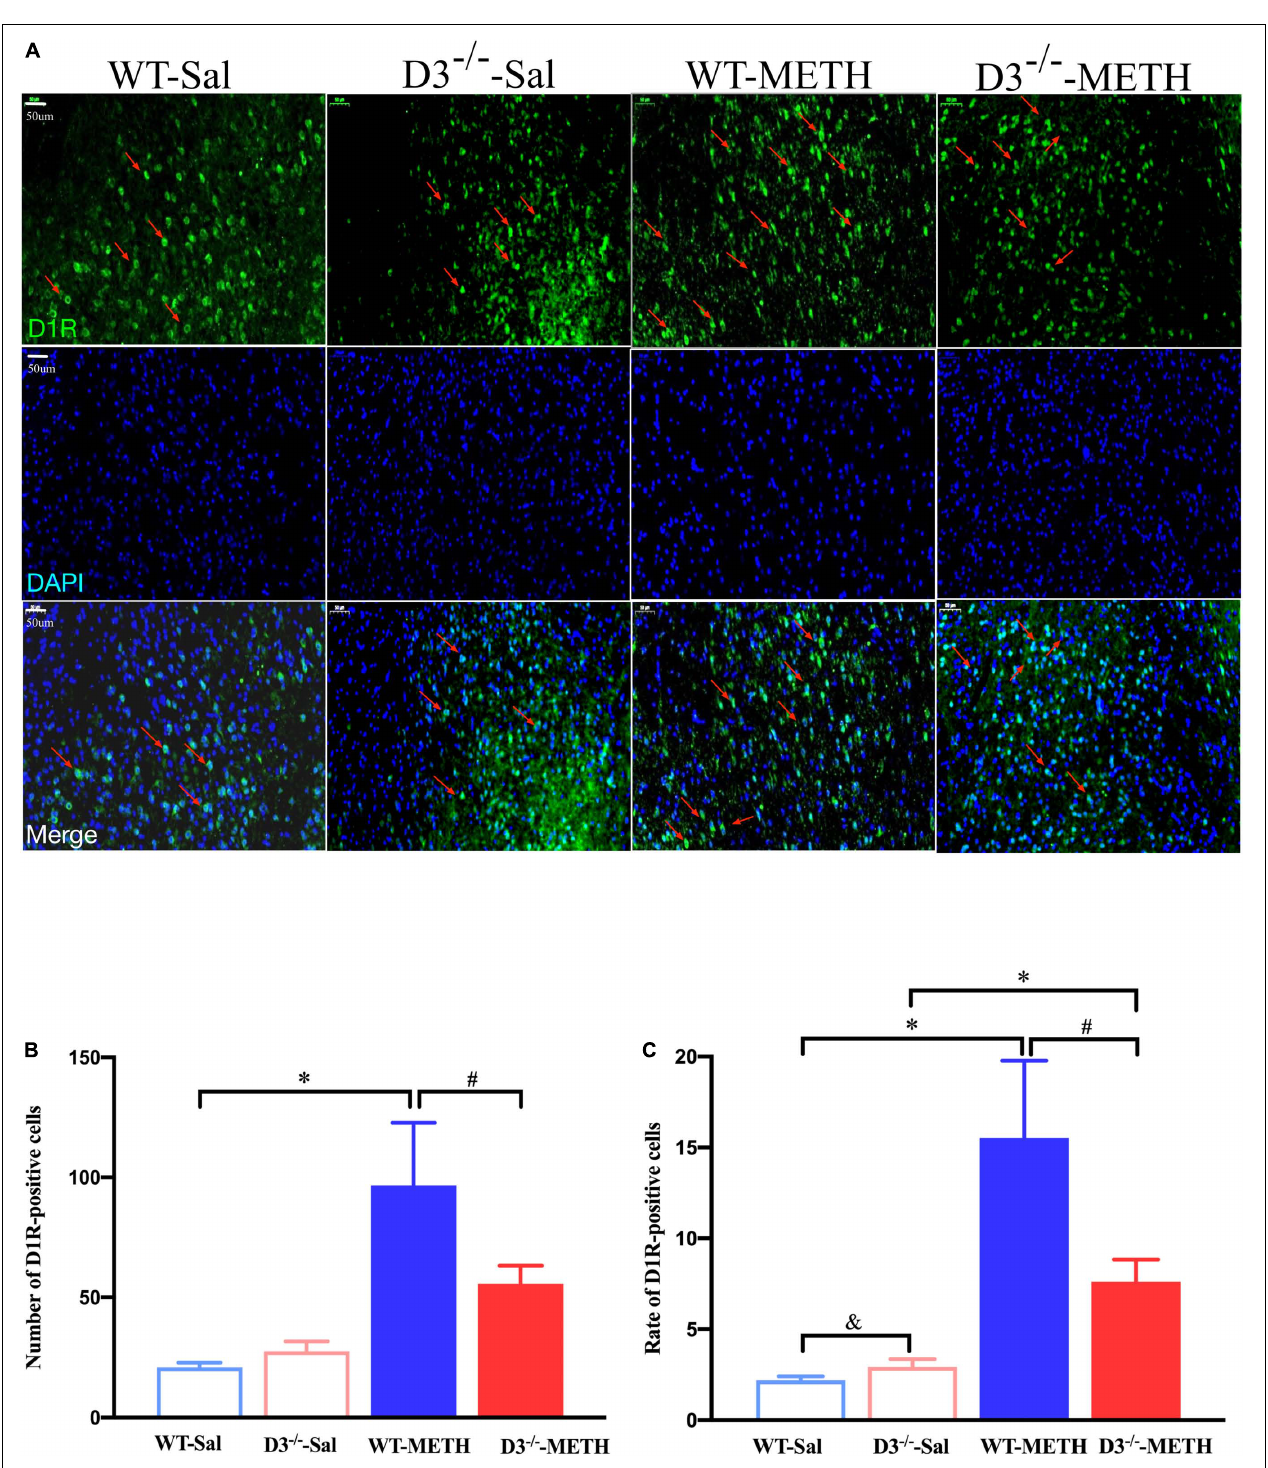
FIGURE 3 | Knockout of dopamine D3 receptor gene blocked the changes of D1R-positive cells in the NAcsh of METH-sensitized mice. (A) Fluorescent staining of the dopamine D1 receptor in the NAcsh. The red arrows indicated the D1R-positive cells. Scale bars = 50 µ m. (B,C) Quantification of the number (B) and rate (C) of D1R-positive cells in the NAcsh of the four groups of mice ( n = 3 mice each). ∗ P < 0.05 compared with the same genotype in saline group; # P < 0.05 compared with same-dose WT mice; & P < 0.05 compared with the different genotype in saline group. Values are presented as mean ± SEM. WT, wild type.